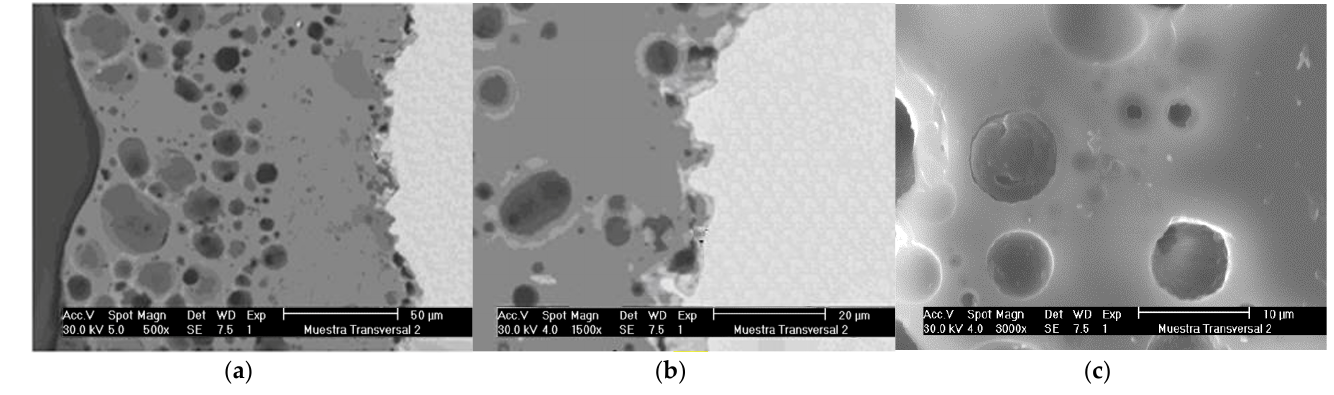
Figure 3. Cross-section micrographs of the coatings produced at 850 °C ( a ) and 820 °C ( b , c ). The data of the EDS point analysis (Figure 4, Table 4) indicate a presence of the chemical elements of the substrate and fritted glass.